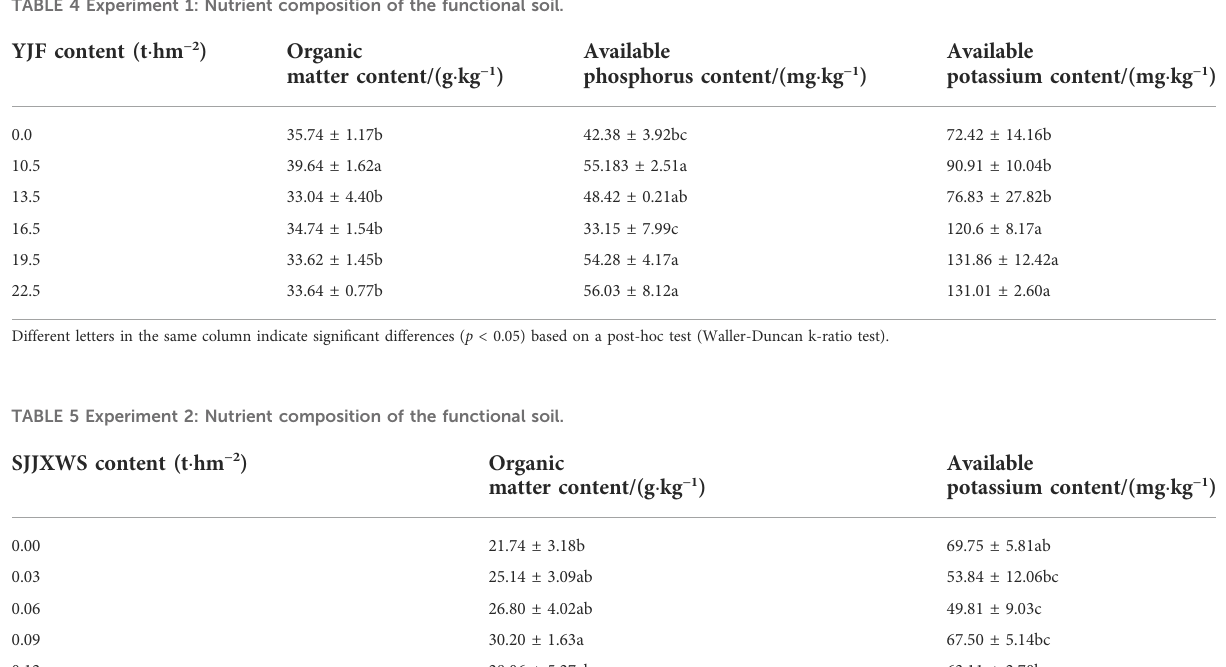
TABLE 4 Experiment 1: Nutrient composition of the functional soil.